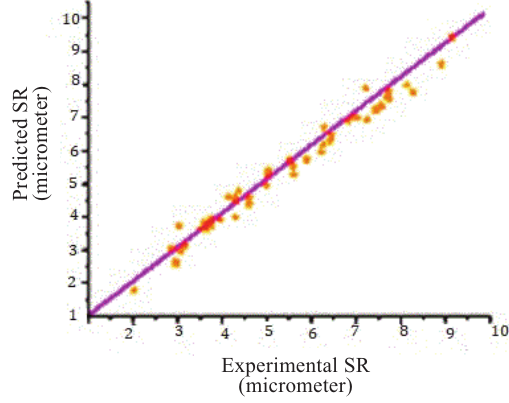
Fig. 4. The actual and predicted values of surface irregularity by 3­6­1 neural